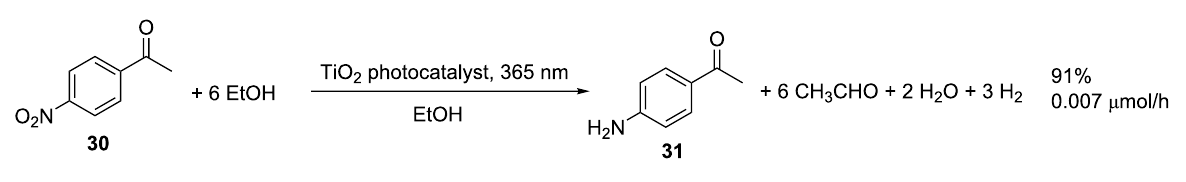
Scheme 11: Photocatalytic reduction of 4-nitroacetophenone.